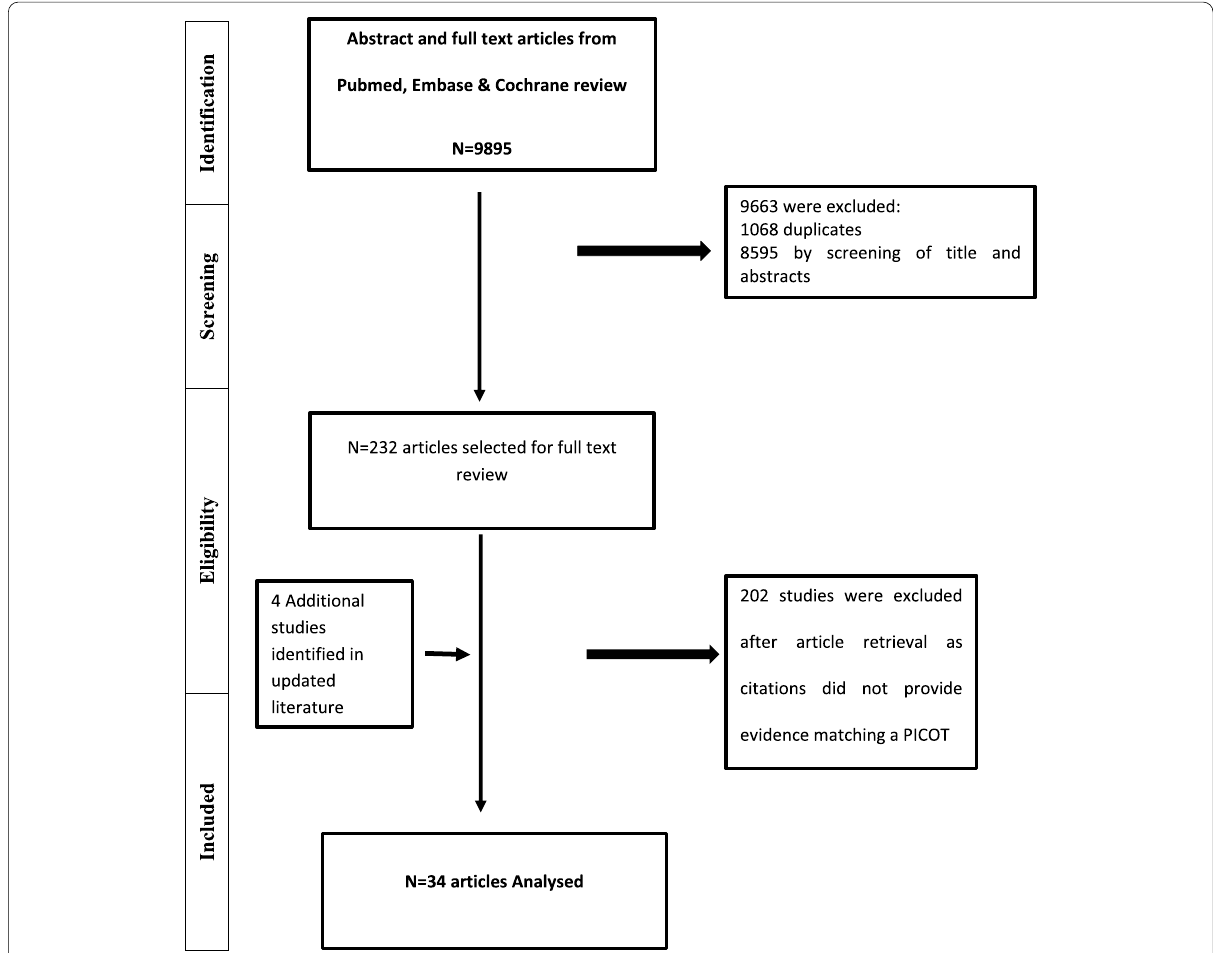
Fig. 1 Flow chart for the systematic review process. PICOT, patient/population, intervention, comparison, outcomes, and